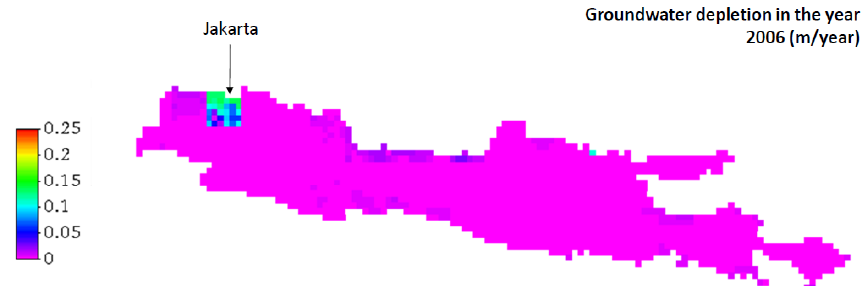
Figure 3. Screen shot of revised depletion (myr − 1 ) results as calculated by the global hydrology model for the island of Java, Indonesia. It shows the depletion of the groundwater as a result of ground water abstraction in the urban area of Jakarta. The calculated depletion in the irrigation areas is now minor.